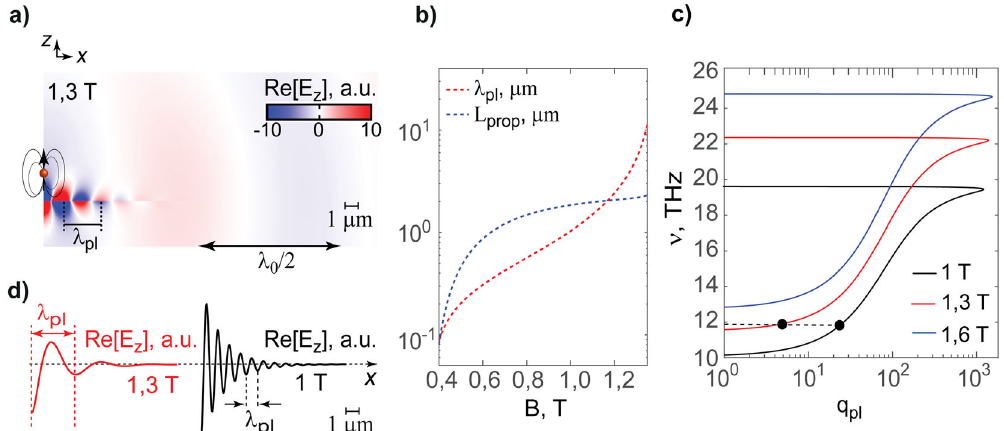
Fig. 2 Dependence of the properties of transverse magnetic graphene plasmon-polaritons (TM GPPs) in charge neutral graphene (CNG) on magnetic fi eld, B . a Electric fi eld snapshot for the TM GPP in magnetized CNG, at B = 1.3 T . b Propagation length and wavelength of the TM GPP in magnetized CNG as a function of the magnetic fi eld. c Dispersion relation for TM GPP in magnetized CNG calculated for different magnetic fi elds. d Real part of the z- component of the electric fi eld, calculated for both B = 1.3 T and B = 1 T (with wavelengths λ p 1 = 4.3 μ m and λ p 2 = 0.97 μ m, respectively). In all panels the frequency v = 12 THz ( λ 0 = 25 μ